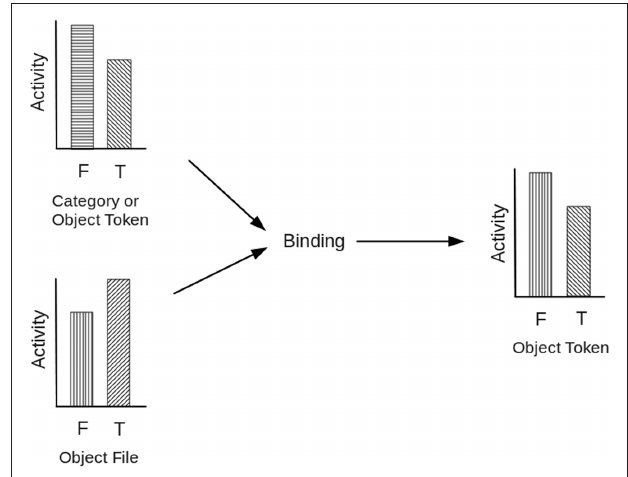
Figure 3 | Schematic representation of trajectory information suppression by binding to an LTM-resident category or object token. The observed trajectory is replaced in the newly bound object token by the abstracted trajectory encoded by the LTM-resident category or object token, while the observed features in the newly bound object token are amplified relative to the trajectory. F, feature information; T,